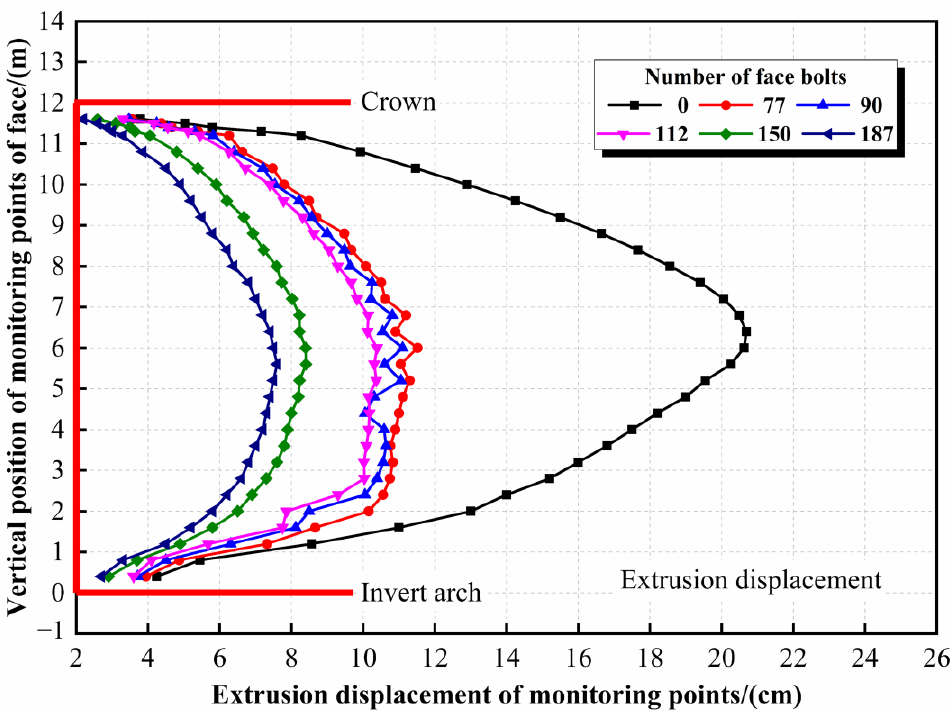
Figure 15. Extrusion displacement of target face under different conditions. Table 9. Maximum displacement and reinforcement effectiveness of tunnel face.